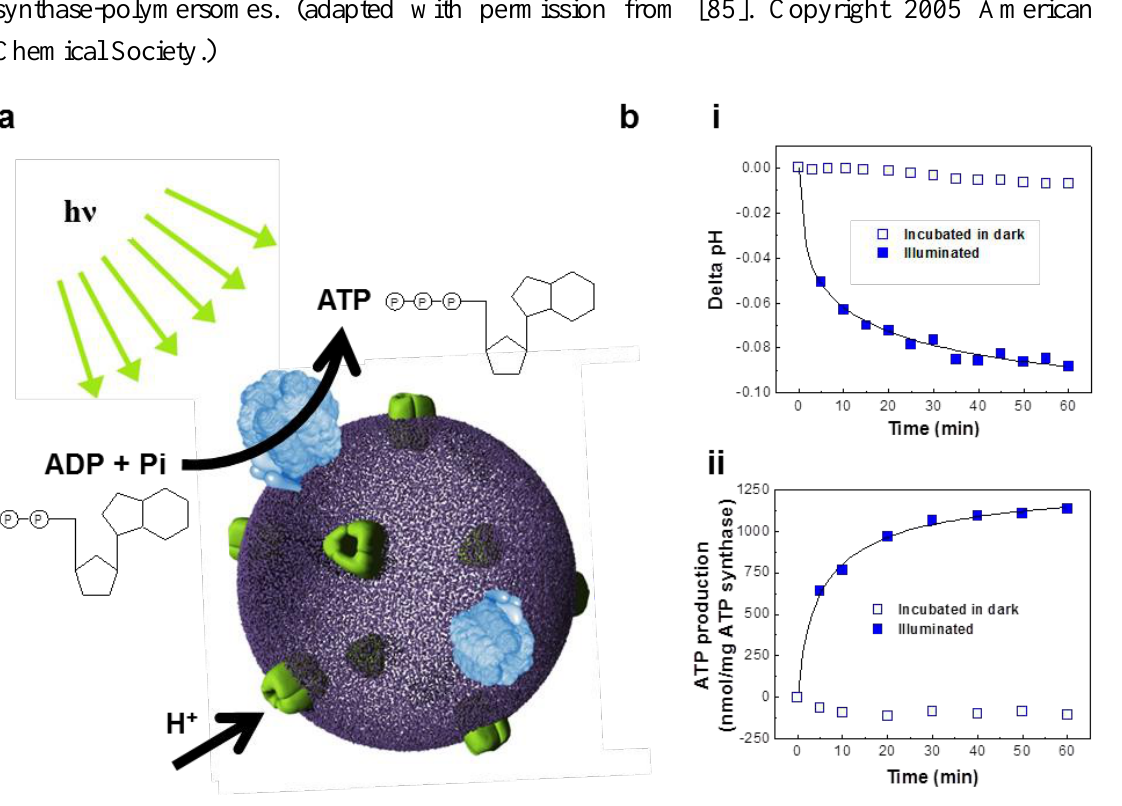
Figure 6. ( a ) Schematic representation of ATP-producing polymersome (BR-ATP synthase-polymersome) (adapted with permission from [43]. Copyright 2007